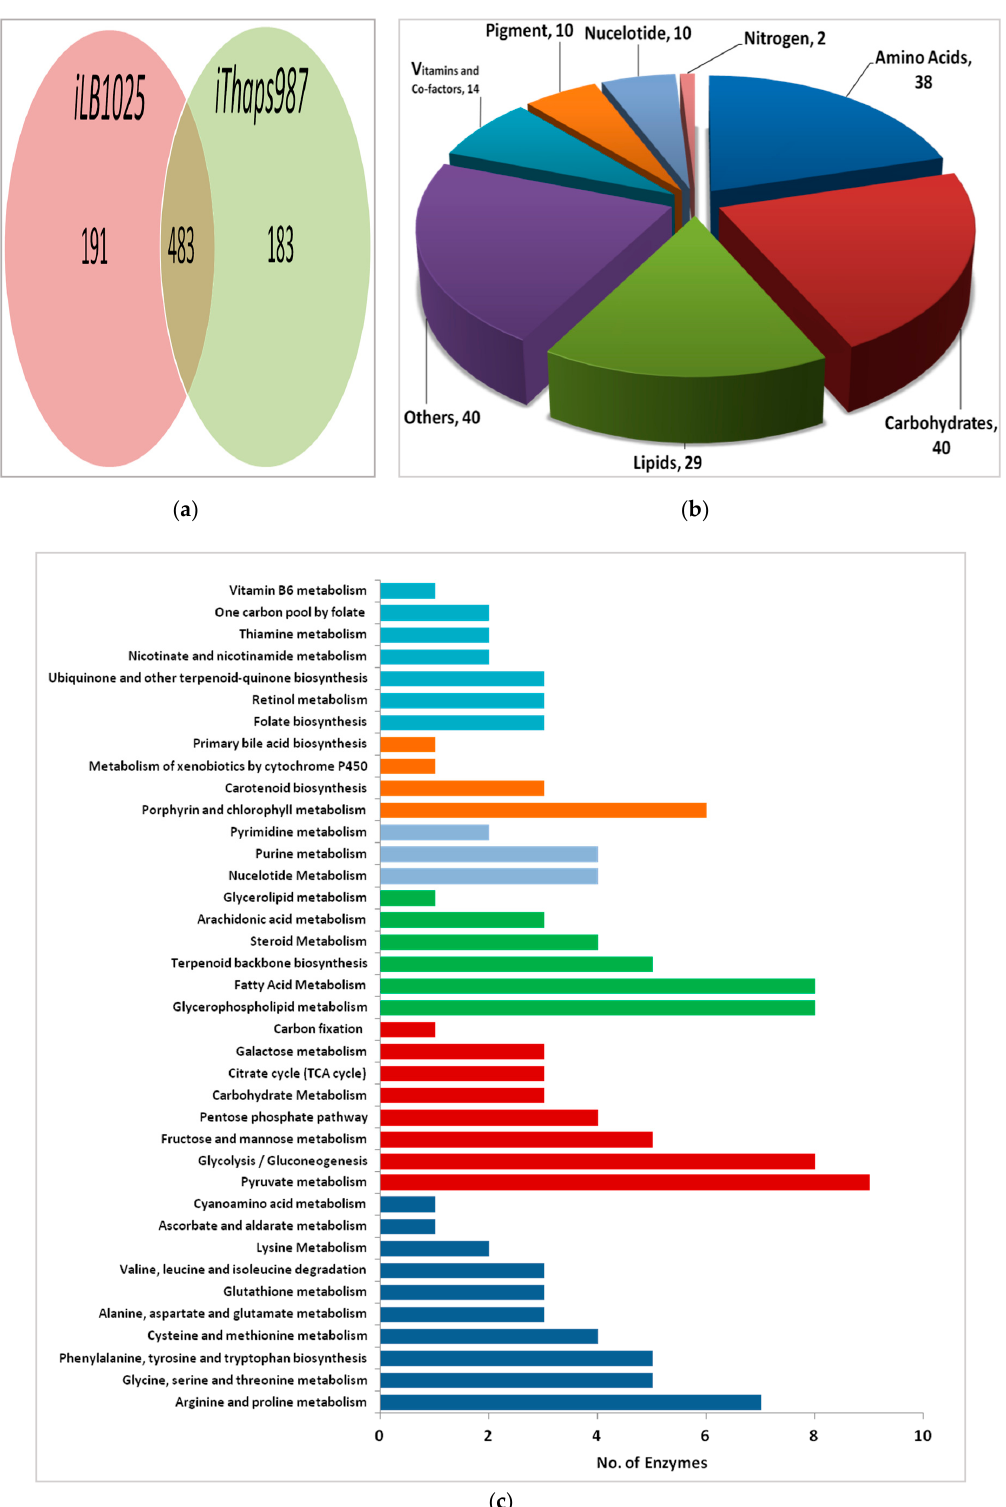
Figure 1. Comparison of two diatom GEMs. ( a ) A Venn diagram showing common and unique enzymes in i Thaps987 and i LB1025 models. ( b ) Distribution of unique enzymes i Thaps987 in various main pathway categories. ( c ) Distribution of unique enzymes in sub-pathways of main pathway categorie s. The color coding follows the colors used for the corresponding pathway in ( b ).